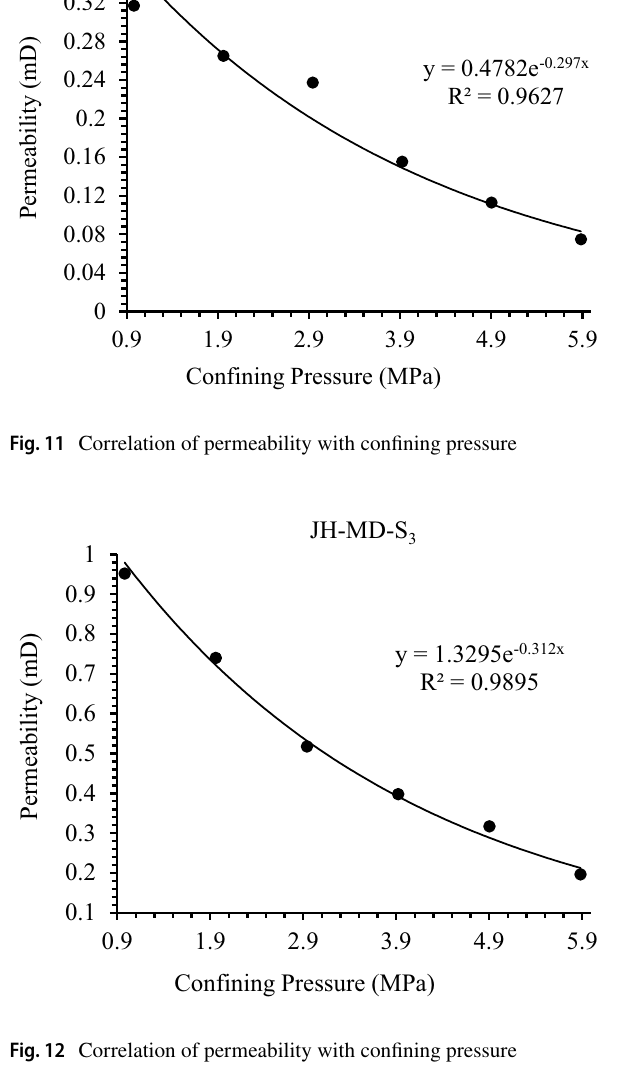
Fig. 12 Correlation of permeability with confining pressure